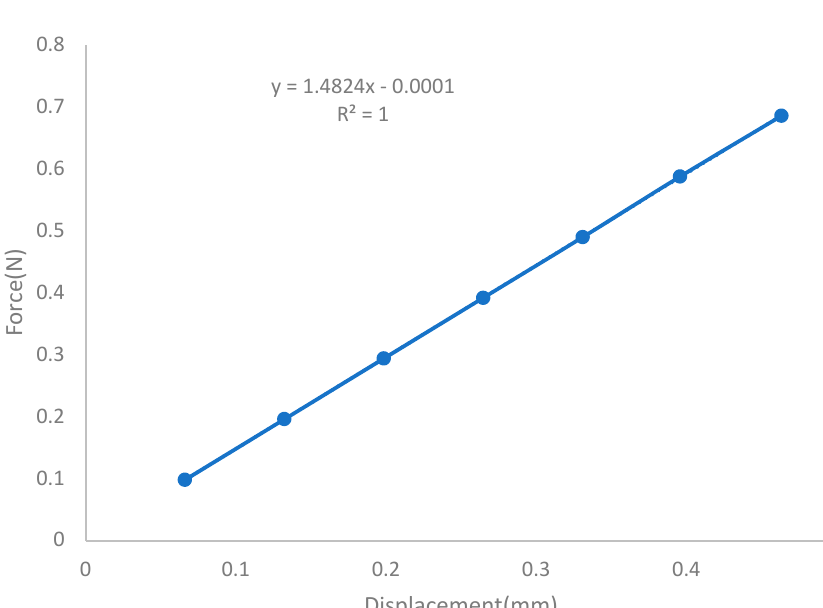
Figure 18. Theoretical relationship between force and displacement.